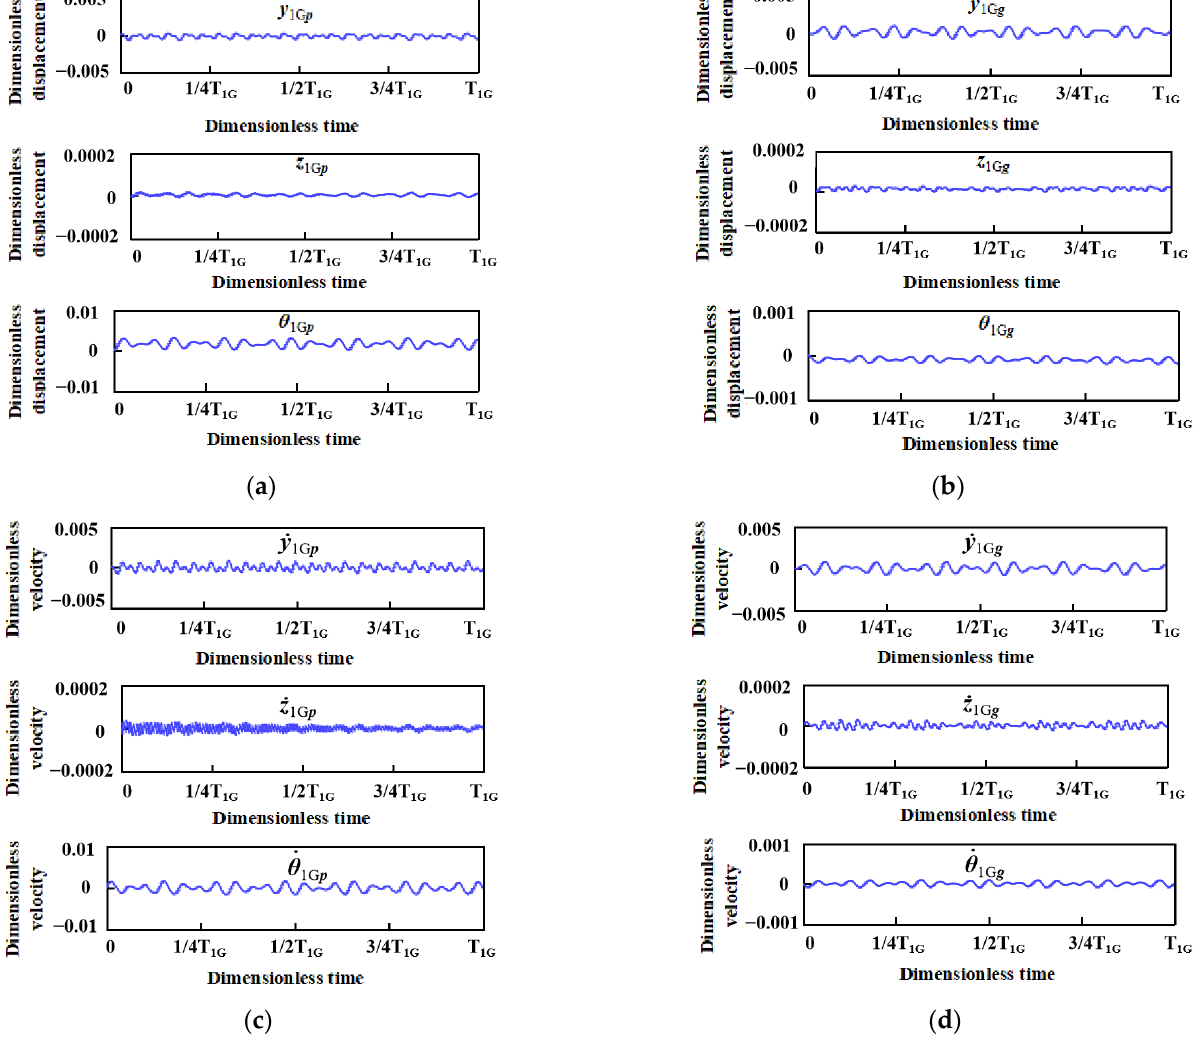
Figure 8. State space of the first-stage gear pair Z 1 and Z 2 : ( a ) vibration displacement of driving gear; ( b ) vibration displacement of driven gear; ( c ) vibration velocity of driving gear; ( d ) vibration velocity of driven gear.